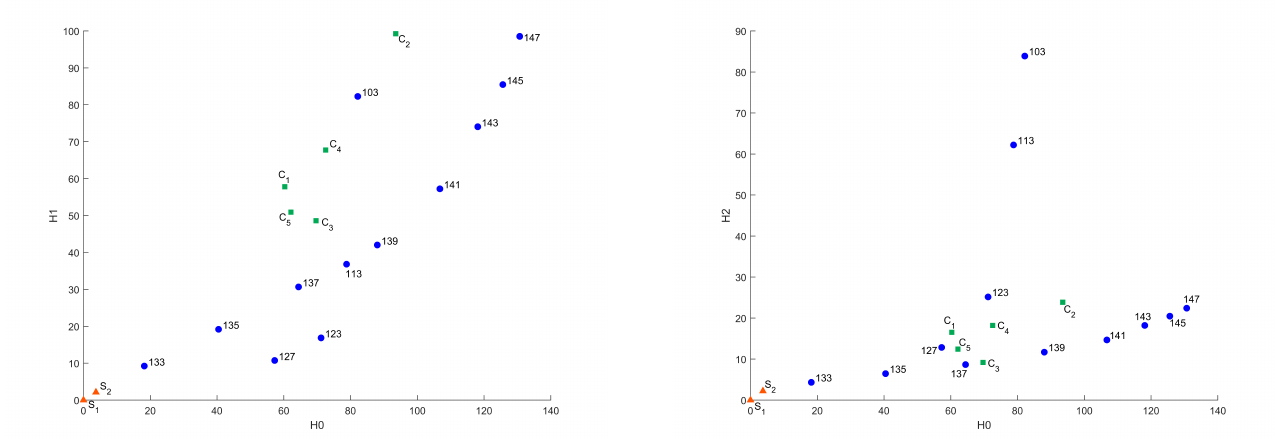
Figure 11. Influence of the binarization threshold of A sample in Heat Kernel metric in H 0 – H 1 and H 0 – H 2